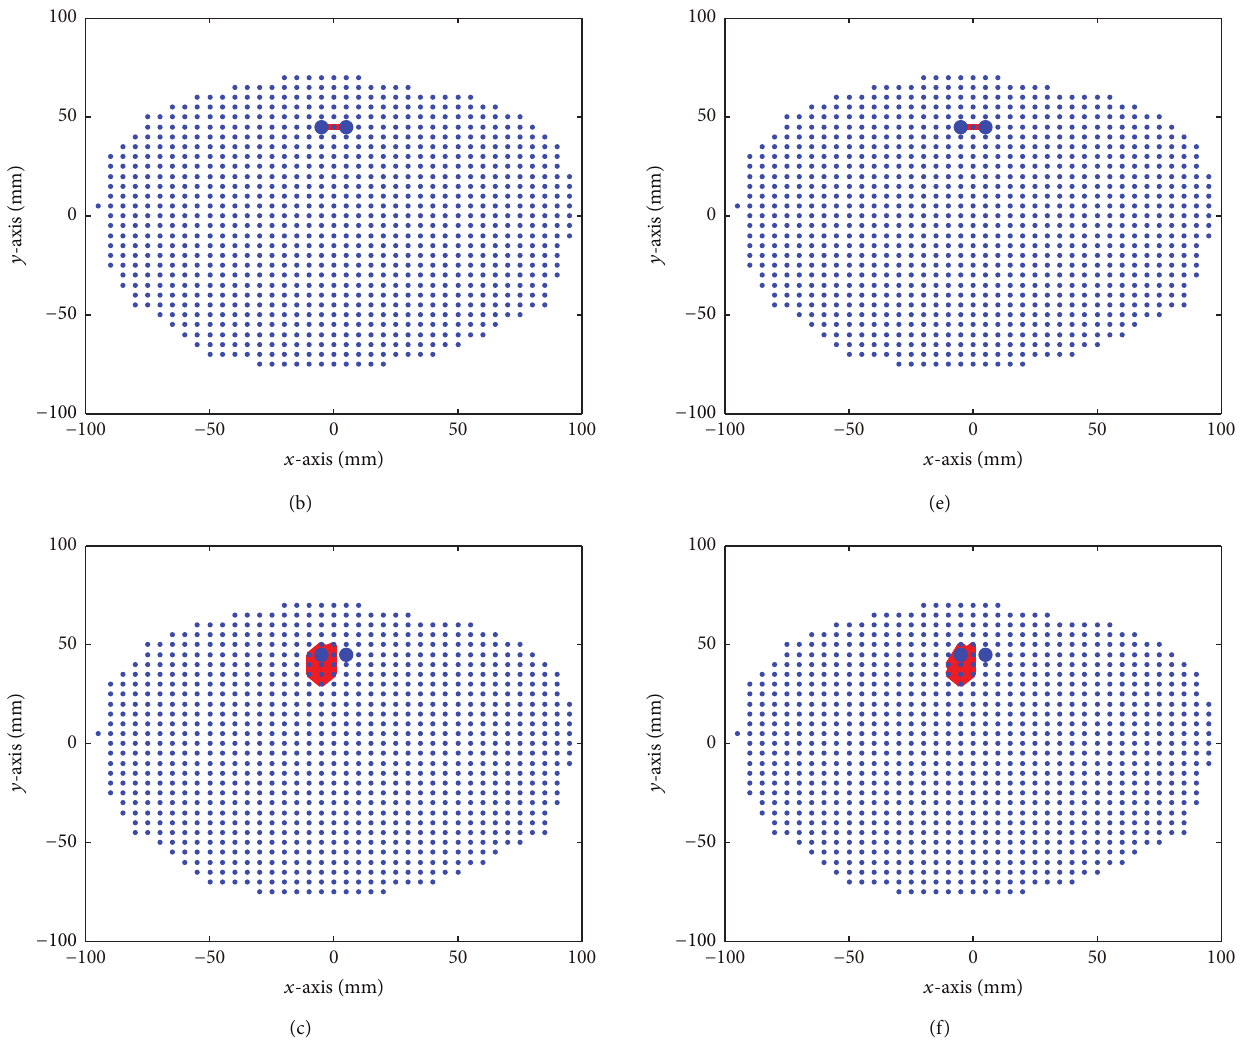
Figure 7: FC graphs based on source reconstruction results using LCMV beamformer, PW-INN, and sLORETA. Real MEG noise was added such that SNR = 18. Small blue dots indicate brain volume grid points, and large blue dots indicate true source locations. (a)–(c) FC graphs estimated from LCMV beamformer (a), PW-INN (b), and sLORETA (c) when 𝑟 2 = 0 between two sources. (d)–(f) FC graphs estimated from LCMV beamformer (d), PW-INN (e), and sLORETA (f), when 𝑟 2 = 0.95 between two